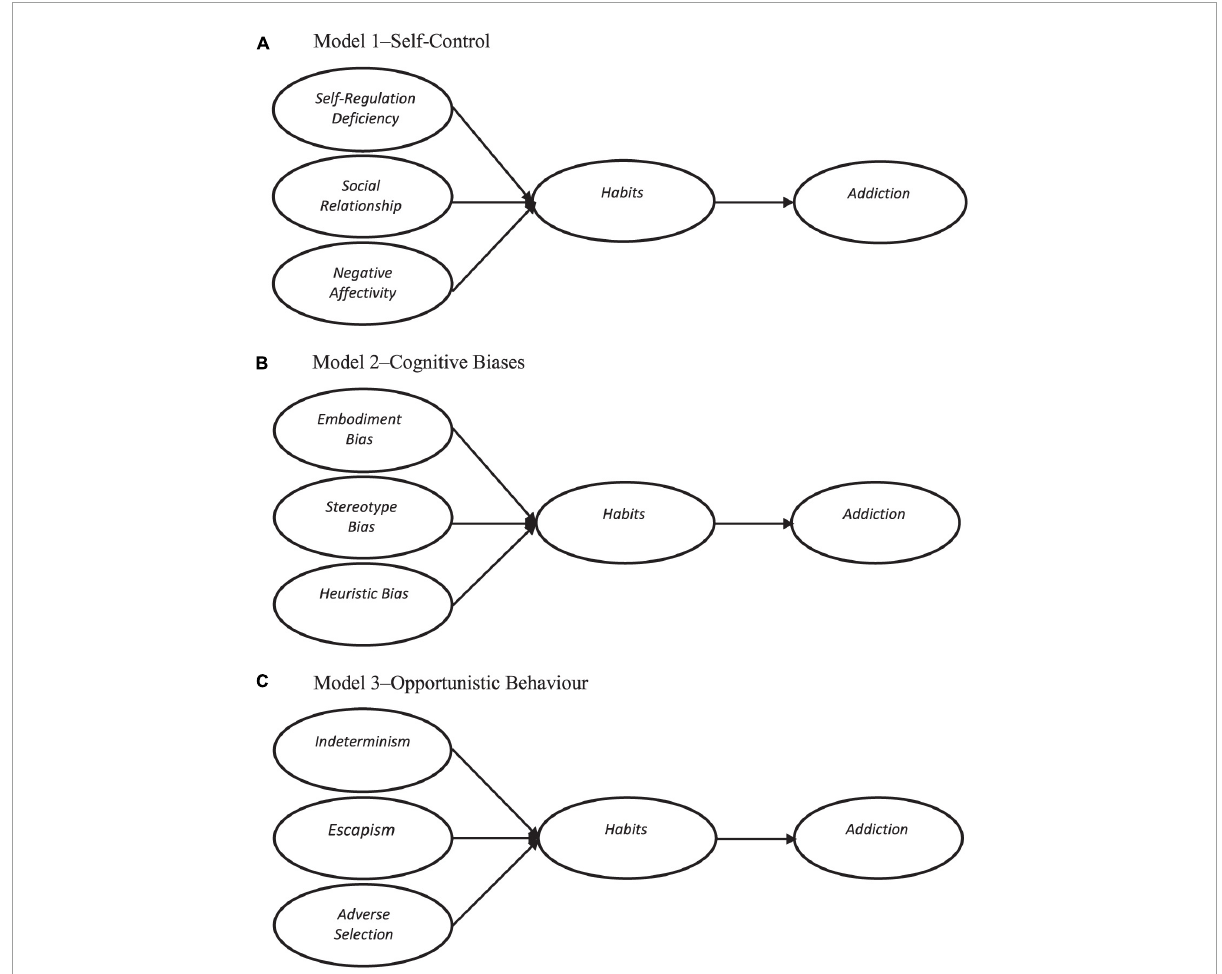
FIGURE1 Three contested models. (A) Model 1-self-control, (B) model 2-cognitive biases, and (C) model 3-opportunistic